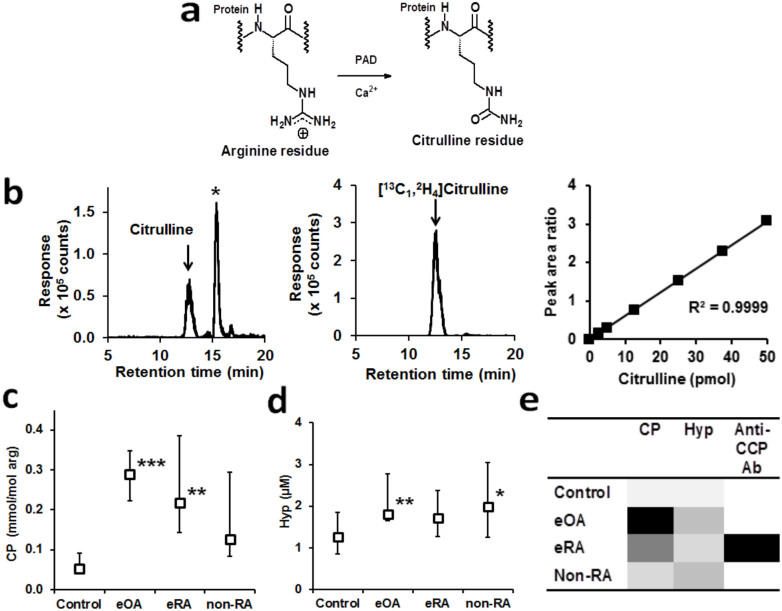
(a) Formation of citrullinated protein. (b) Analysis of citrullinated protein. Detection and quantitation of citrulline by stable isotopic dilution analysis LC-MS/MS. Left-hand panel – MRM chromatogram of citrulline in plasma protein digest from patient with eOA, middle panel - MRM chromatogram of [5-13C-4,4,5,5-2H4]citrulline internal standard (5 pmol), right-hand panel – calibration curve of citrulline/[5-13C-4,4,5,5-2H4]citrulline MRM chromatographic peak area ratio against citrulline standard (pmol). (c) Citrullinated protein (CP) and (d) hydroxyproline (Hyp) in early-stage arthritis and healthy human subjects. Samples were plasma for Control (n = 16) and eOA (n = 16) and serum for eRA (n = 10) and non-RA (n = 10). Significance: *, ** and ***, P < 0.05, P < 0.01 and P < 0.001 with respect to control (healthy people). Data are median (lower – upper quartile). (e) Discrimination of study groups by discrete patterns of CP, Hyp and Anti-CCP antibody response. Each darkened shade presents approximately a 2-fold increase.